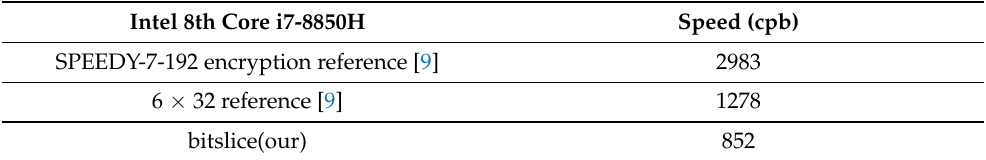
Table 1. Comparison of reference and bit-slicing C implementation results. Performance is evaluated in cpb (clock cycles per